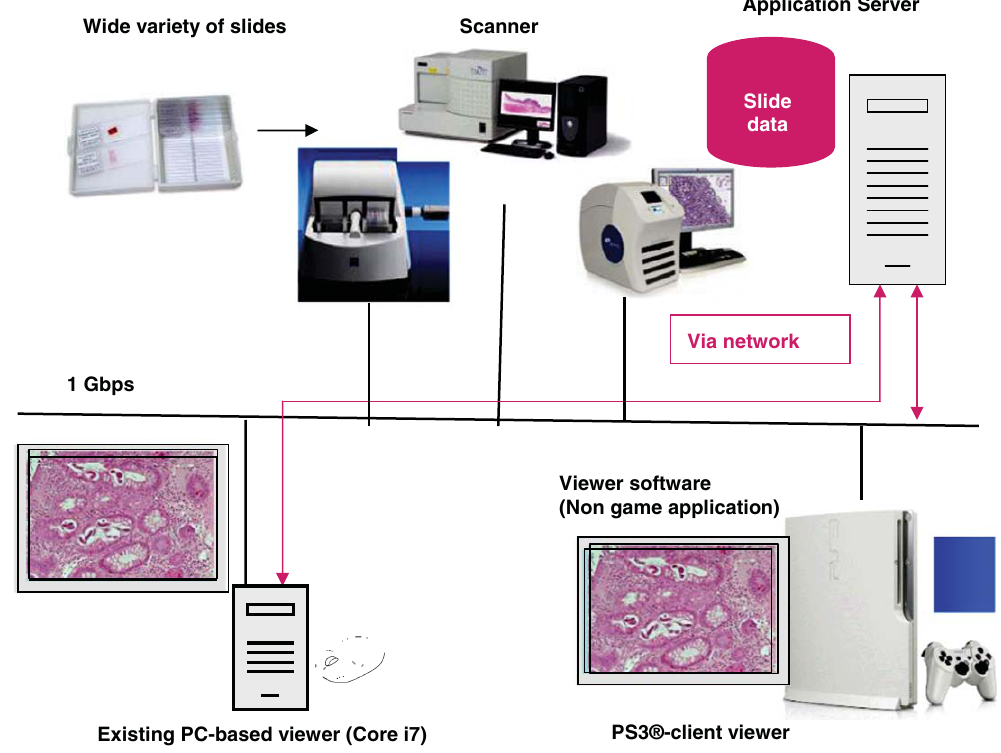
Fig. 6. The prototype WSI viewing system based on PS3 ® : Server Client. Client viewer accesses the images in the storage server located at the Imaging Laboratory at MGH through the application server. Existing PC-based viewers access the images in the same storage server. All scanners send the data to the storage server at the time of